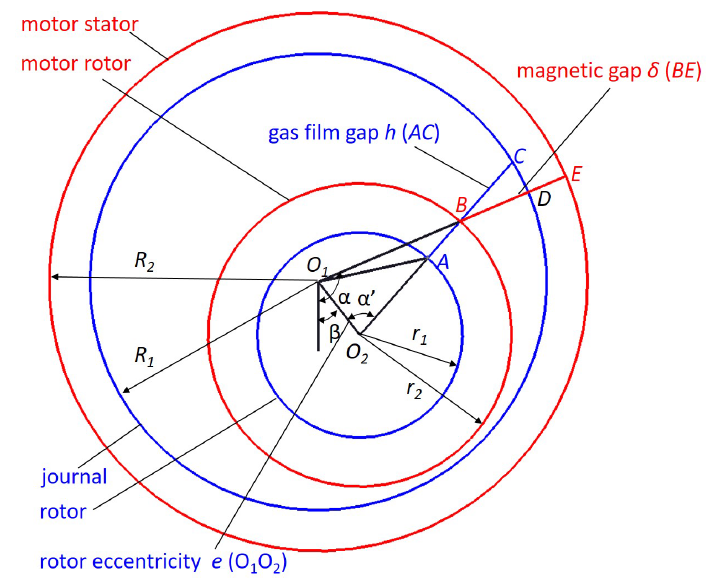
Figure 3. Aerostatic motorized